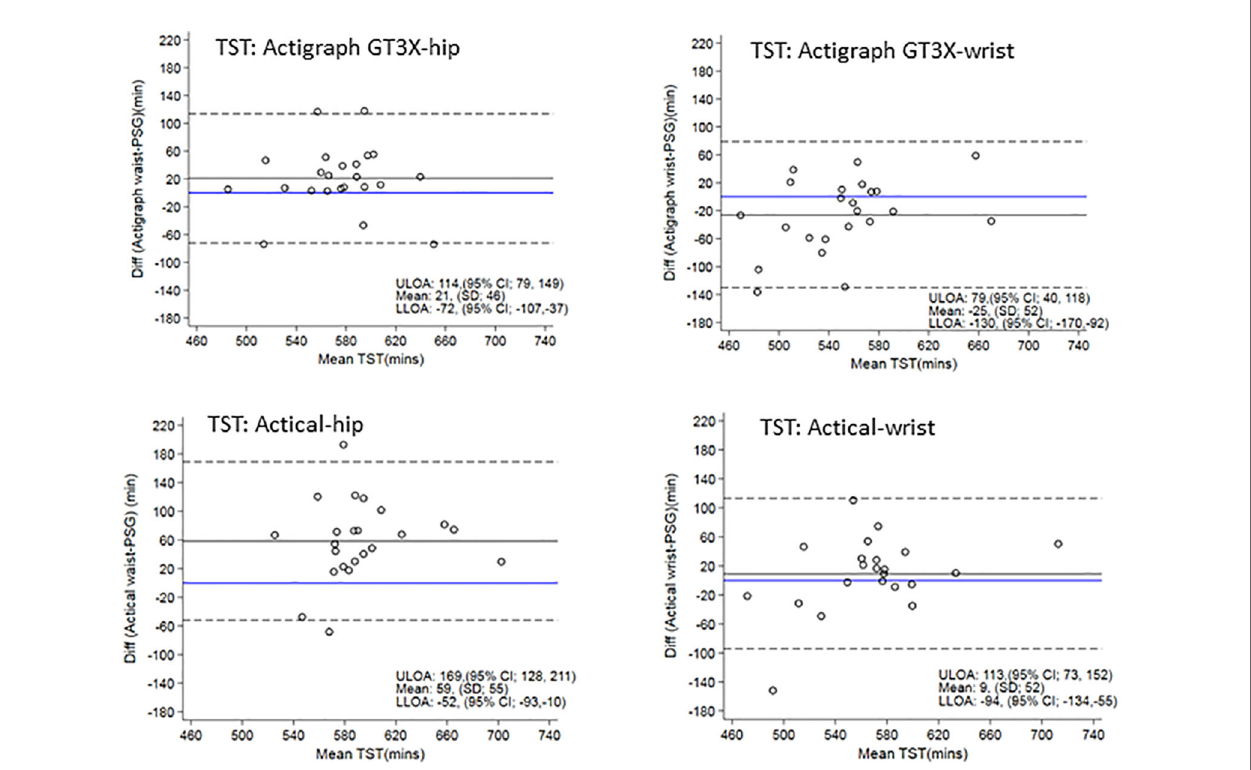
FIGURE 3 | Bland Altman plots of TST differences between actigraphy and PSG are on the y-axis and means are on the x-axis. Perfect agreement is shown by the blue line crossing zero on the y-axis. Mean differences are represented by black solid lines and the upper and lower levels of agreement by dashed lines. ULOA, Upper Limit of Agreement; LLOA, Lower Limit of Agreement; TST, Total Sleep